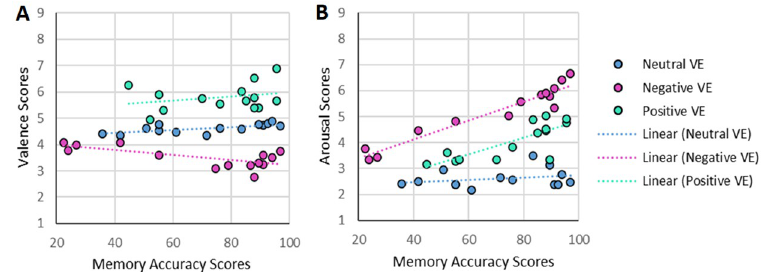
Fig 5. Panel A—relationship between valence ratings (y-axis) and memory accuracy for each event/object. Panel B— relationship between arousal rating (y-axis) and memory accuracy (x-axis) for each event/object. Red dots represent events/objects from the negative VE condition, green dots represent events/objects from the positive VE condition, and blue dots represent events/objects from the neutral VE condition.